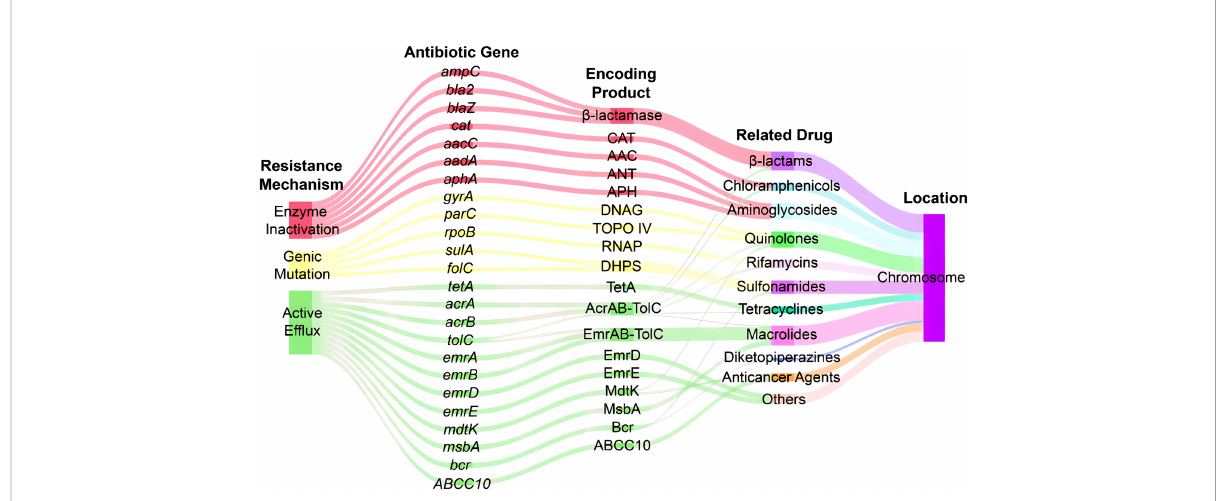
FIGURE 4 Sankey diagram of distribution of resistance-associated genes in A. hydrophila MX16A. CAT, chloramphenicol acetyltransferase; AAC, acetyltransferase; ANT, adenylyltransferase; APH, phosphotransferase; DNAG, DNA gyrase; TOPO IV, topoisomerase IV; RNAP, RNA polymerase; DHPS, dihydropteroate